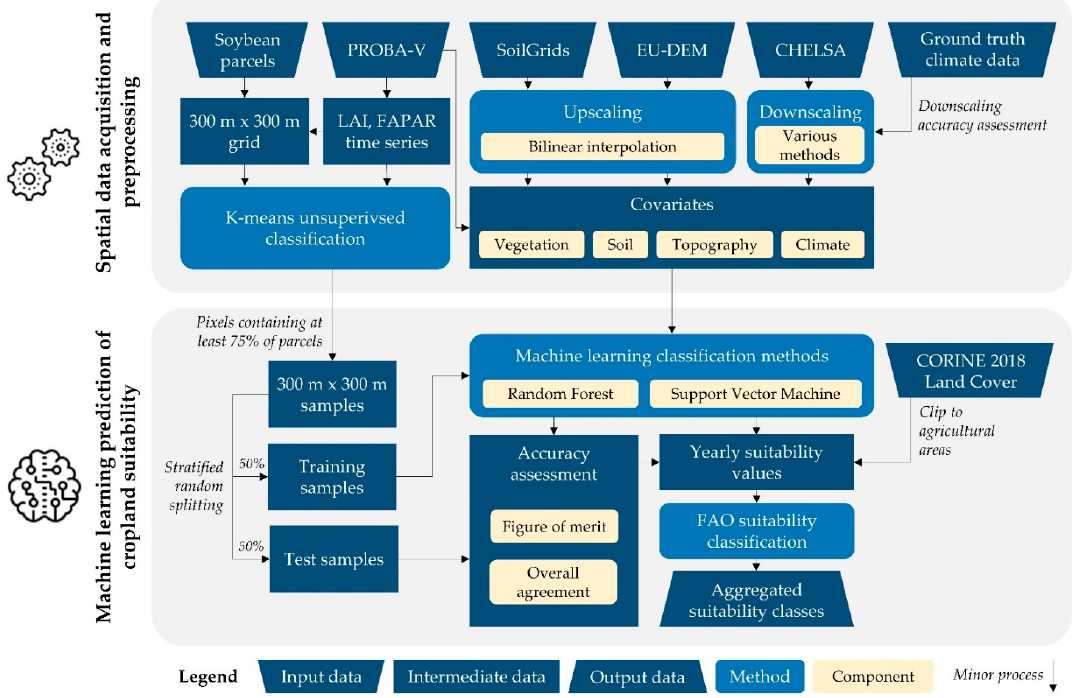
Figure 2. Workflow of the proposed cropland suitability assessment method.